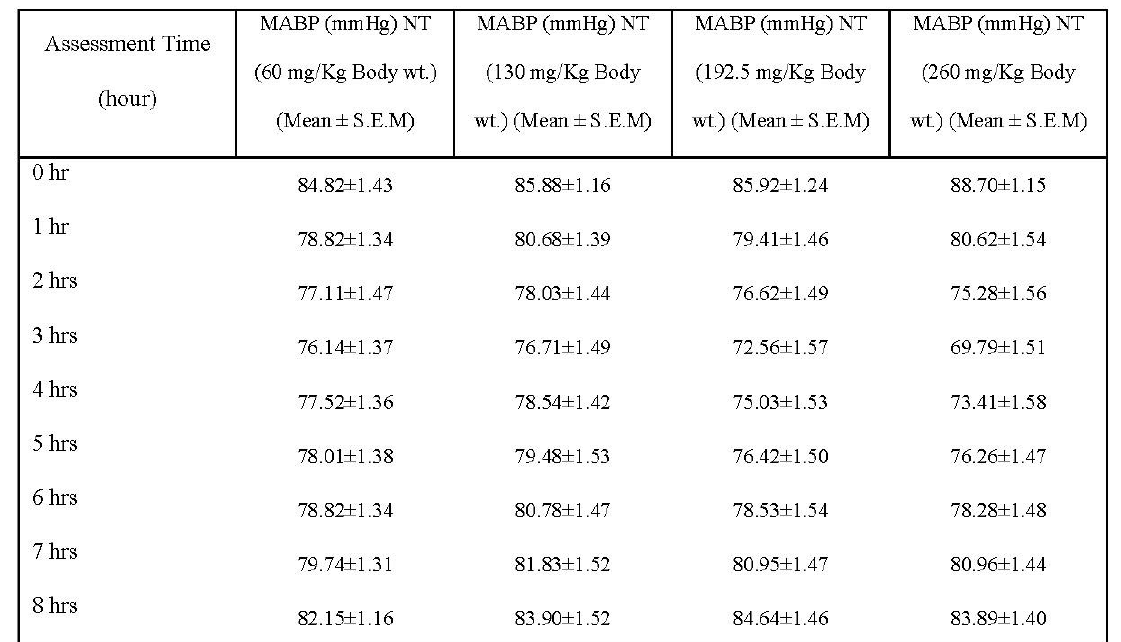
Table 2 : MABP across the different time of assessment after administering CSAE compared to water (control) in normotensive subjects (NT).